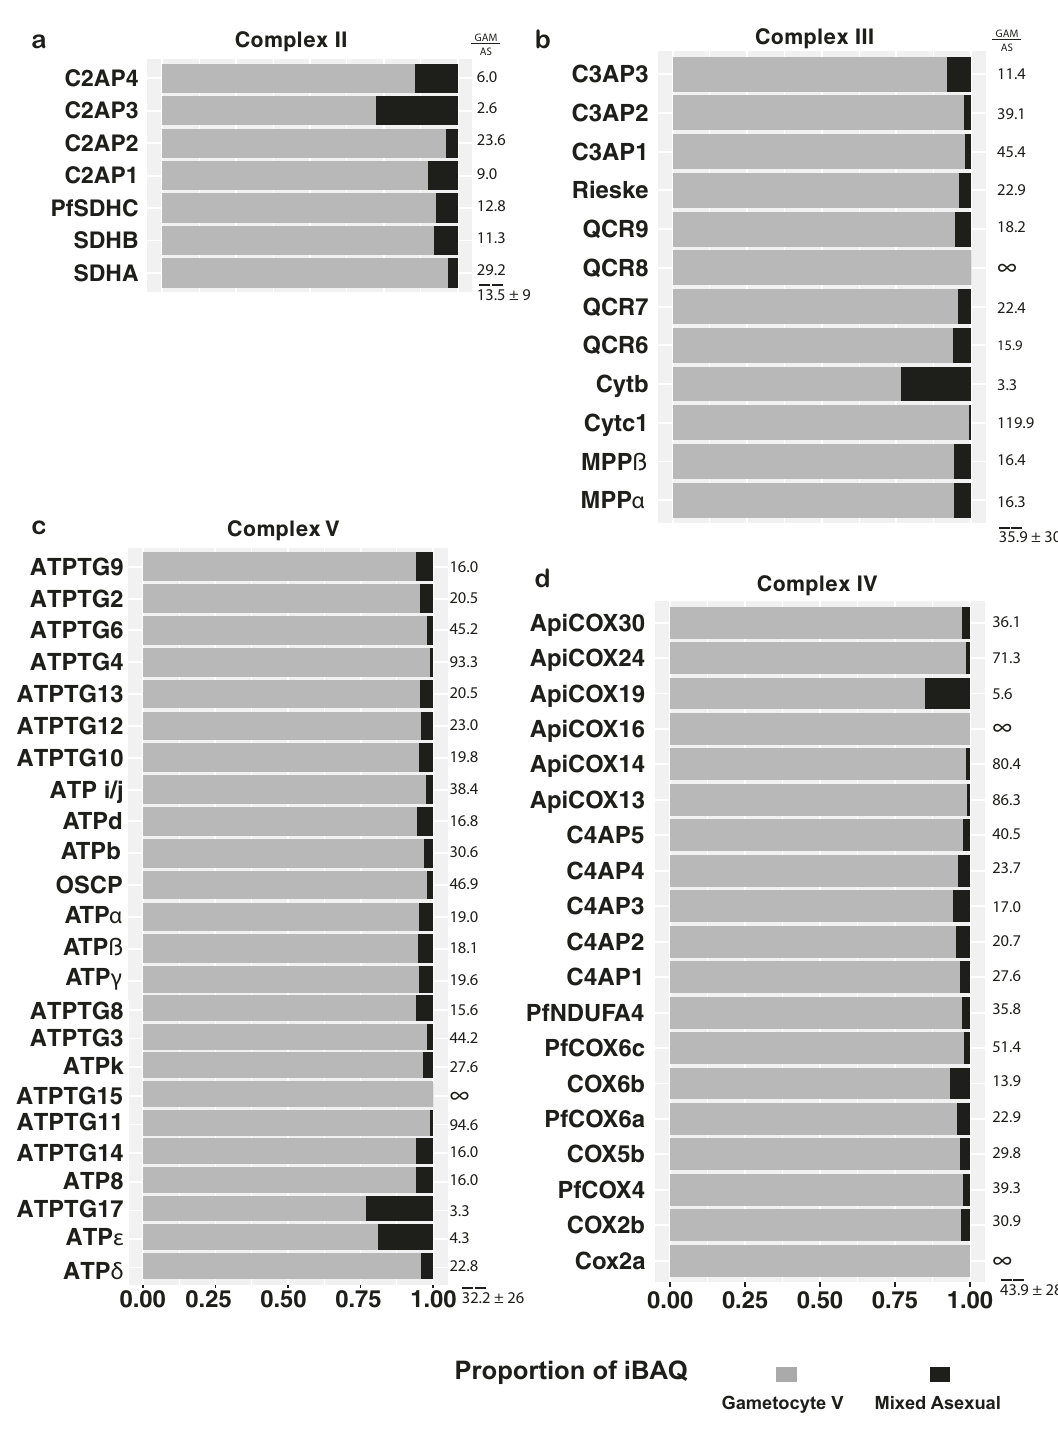
Fig. 6 Relative quanti fi cation of respiratory chain complex components. Relative abundance expressed in proportion of iBAQ of OXPHOS components in ABS parasites (black) and gametocytes (grey). Data are based on denatured whole-cell lysates separated by SDS-PAGE and analyzed by label-free quantitative MS. Fold differences are indicated next to each bar and for each complex a mean ± SD are indicated below dashed lines. In fi nite fold changes were arbitrarily treated as 100 for mean/SD calculations. a Putative components of CII. b Putative components of CIII. c Putative components of CV. d Putative components of